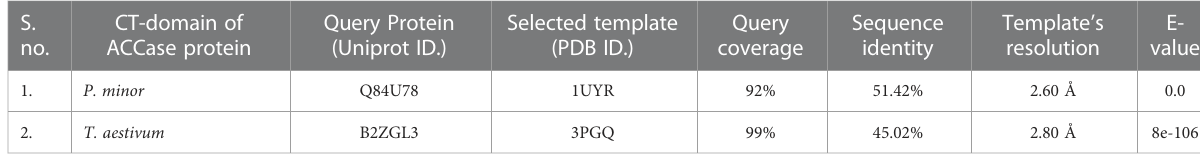
TABLE 1 Selection of template for modelling of P. minor and T. aestivum ACCase CT-domain. S. no.